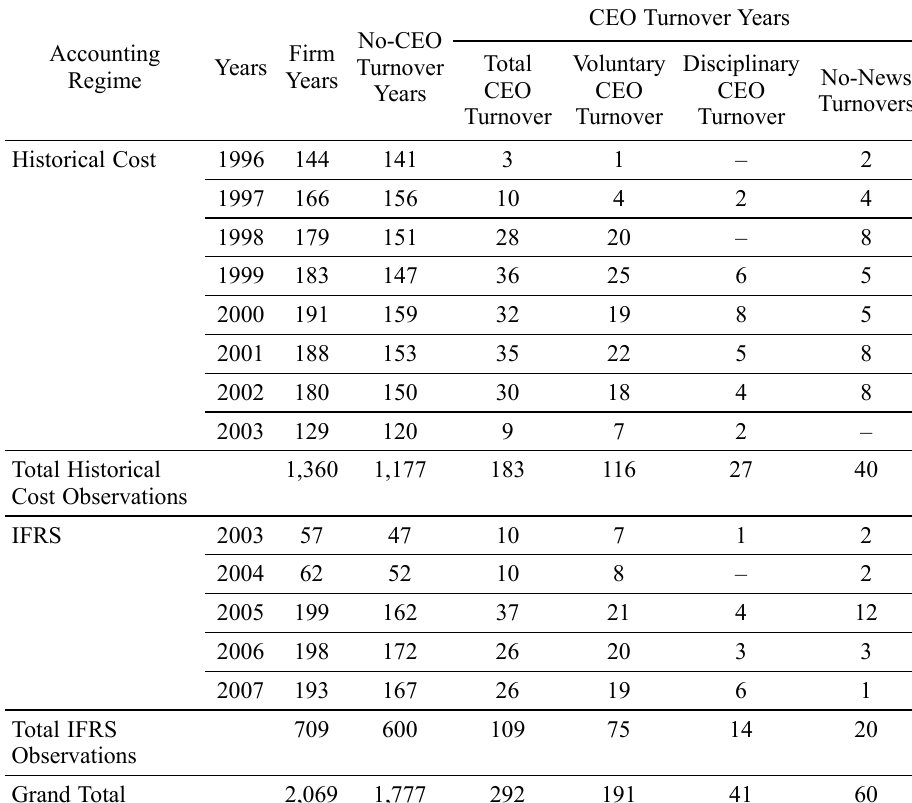
Table 1. Distribution of CEO